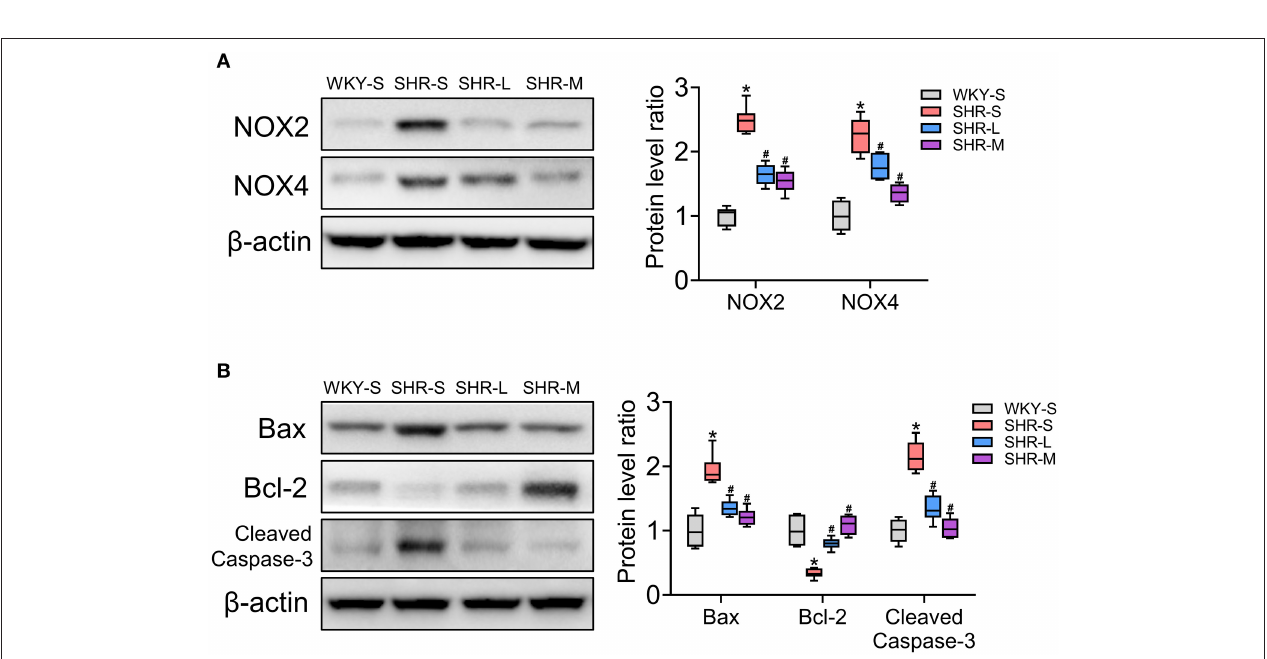
FIGURE 2 | Effects of aerobic exercise training on (A) NOX2 and NOX4, and (B) Bax, Bcl-2, and cleaved-caspase-3 protein expression in kidney of SHR. Data are presented as Box-whisker Plot. * P < 0.05 (WKY-S vs. SHR-S), # P < 0.05 (SHR-L, SHR-M vs. SHR-S).